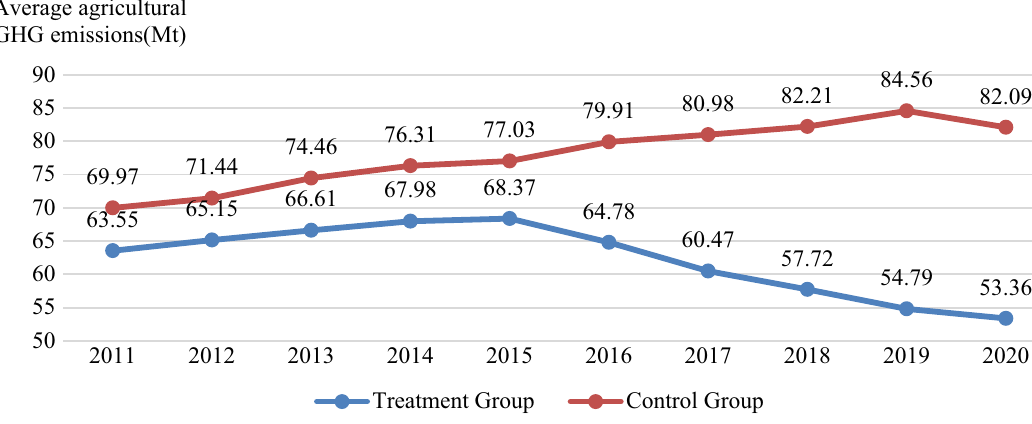
Fig. 6 Changes in average agricultural GHG emissions in the 2 Groups (2011–2020). Note: GHG emissions in Figs. 4, 5, and 6 were calculated by the author based on the data of each emission source Table 7 Regression results of Variable the first-order difference value of agricultural GHG emissions before 2016 based on the fixed effects model